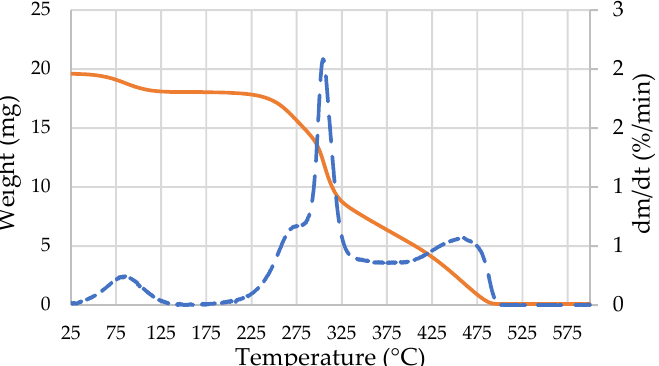
Figure 2. TGA (orange line) and DTG (blue dotted line) curves from the heartwood degradation.